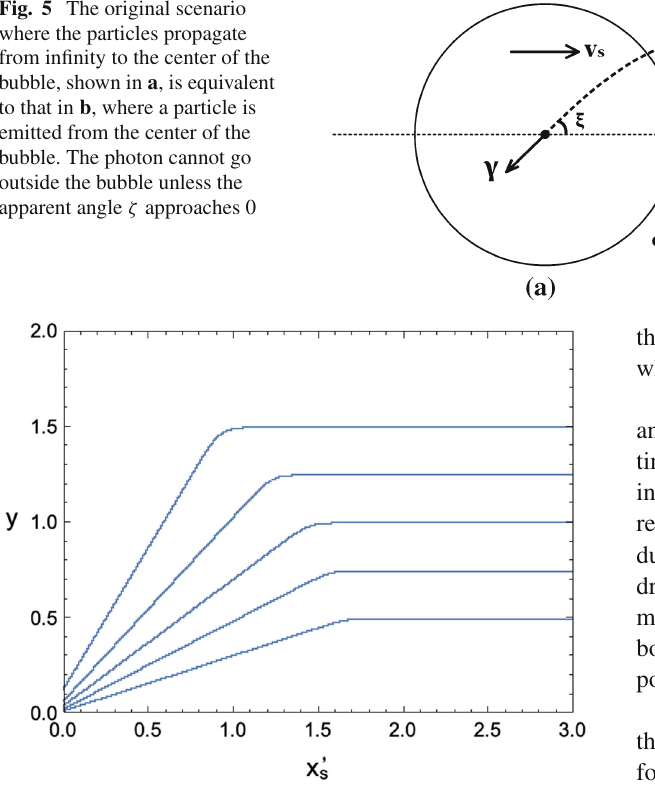
Fig. 6 The trajectories of dust particles with a large initial x position, and initial y positions at y = 0 . 5, y = 0 . 75, y = 1, y = 1 . 25 and y = 1 . 5 respectively. The parameters of the warp bubble read σ = 10, R = 2, v s = 100. All numerical values are in natural units. Here, x (cid:7) s ≡ x − v s t represents the apparent distance of dust and spaceship in x axis, so x (cid:7) s = 0 means spaceship and dust have the same x coordinate in the view of the remote